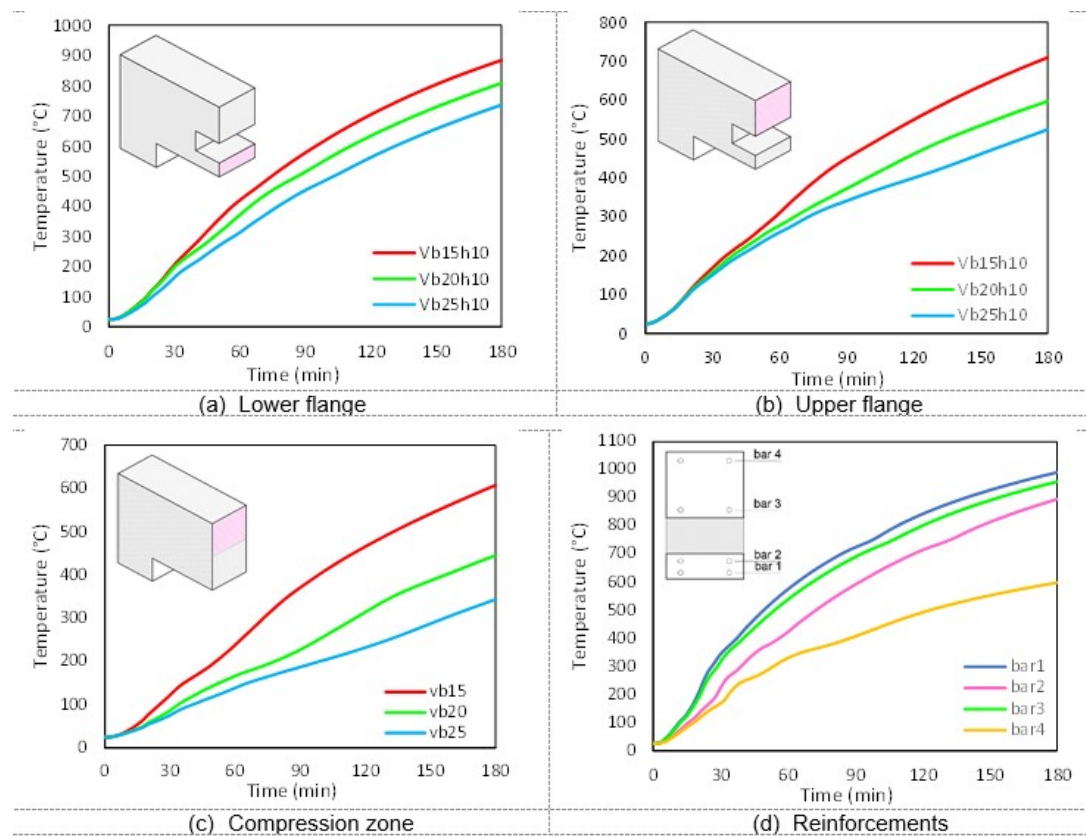
Figure 5 – Thermal field in (a) lower and (b) upper flange of the concrete (beam with opening), (c) in the compresses region of the concrete (beam without opening) and (d) in the